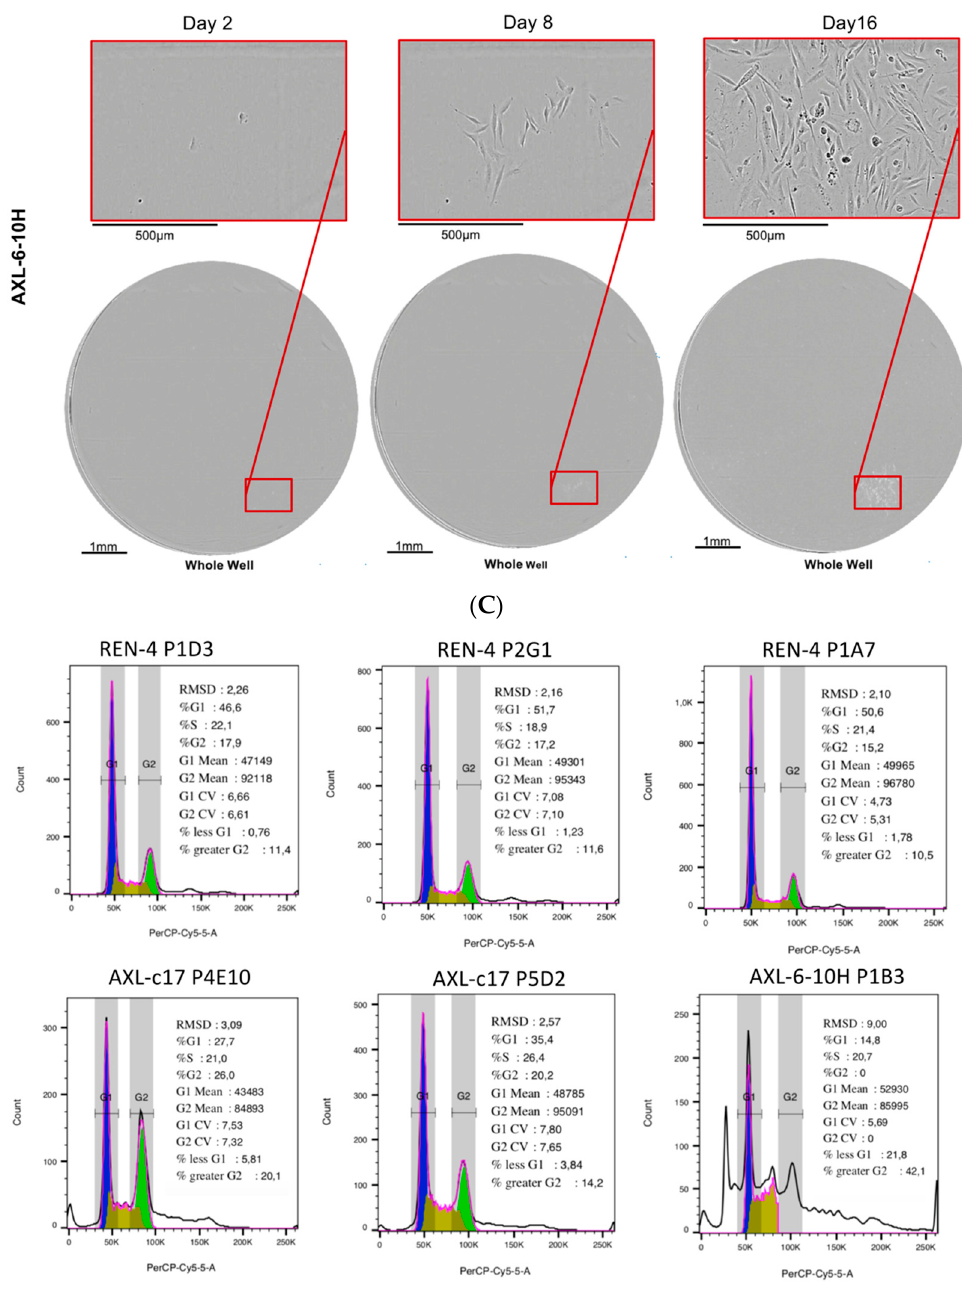
Figure 6. Clonality-proliferation assay and cell cycle distribution of single-cell clones REN-4, AXL-c17, AXL-6-10H. ( A – C ) Representative clonality-proliferation images of REN-4, AXL-c17, AXL-6-10H at days 2, 8, 16, respectively. ( D ) The cell cycle analyses of randomly selected clones from clonality-proliferation assay.